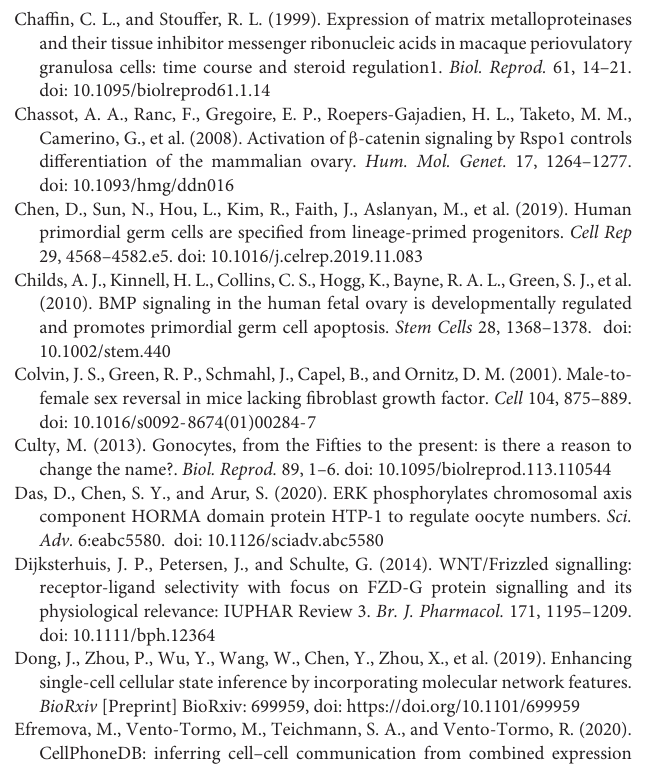
Supplementary Figure 3 | Positive controls for antibodies recognizing phosphorylated proteins. (A) Positive control experiment for antibodies recognizing phosphorylated proteins. HEK293T cells, cultured with 10% FCS (left panels), were serum starved for 16 h (middle panels), treated for 30 min with the indicated growth factors (right panels), and immunostained for the respective antibodies (pERK, pSAPK/JNK, p-p38MAPK, pSMAD1/5/9, pSMAD2, and pSMAD3). Scale bars indicate 50 µ m. (B) Positive control staining for pSMAD2 and pSMAD3 antibodies on fetal intestine. Nuclear pSMAD2 and pSmad3 were observed in intestinal endoderm. Scale bars indicate 50 µ